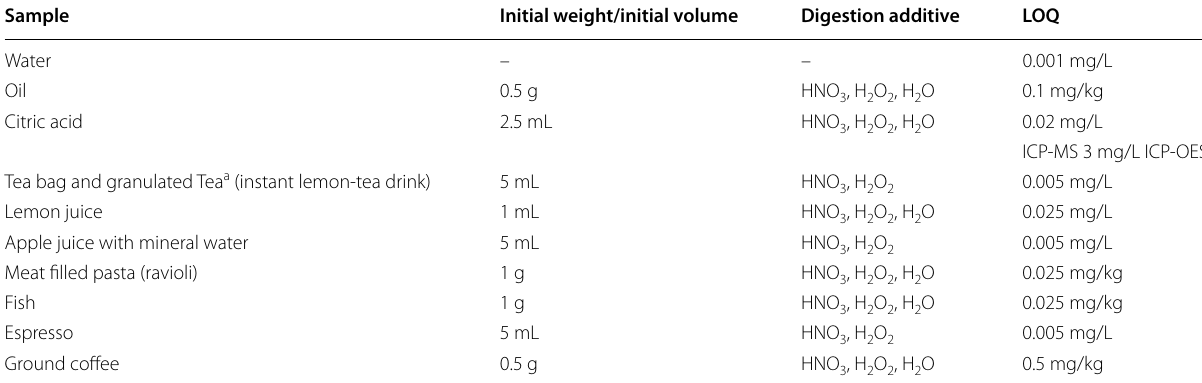
Table 6 Sample materials with initial weight, digestion additives and LOQ